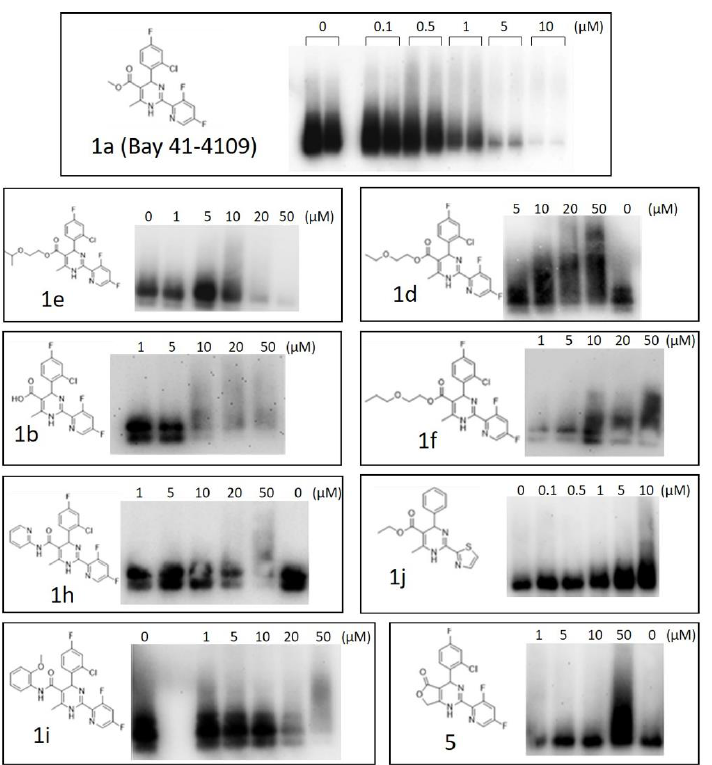
Figure 6. Dose-dependent effects of selected compounds on the assembly of HBV capsids in mammalian cells. Native agarose gel electrophoresis and subsequent anti-HBc immunoblotting of the cell lysates is shown. BHK-21 cells were infected with SFV1/HBc (D1 genotype) to express full length HBc gene. After 4 h, the cell culture medium was replaced with compound-containing medium, and after 24 h of incubation the cell medium was removed and the lysates were loaded on agarose gel. Equal total protein amount was tested. The concentrations (in a range 0.1 – 50 µM) are indicated on the top of each immunoblot. The concentration “0” (without compound) for comp. 1b test corresponds to the line “0” in comp. 1h immunoblot; the concentration “0” for comp. 1f test corresponds to the line “0” in comp. 1d immunoblot, because it was the same run for both compounds with shared untreated HBc control.